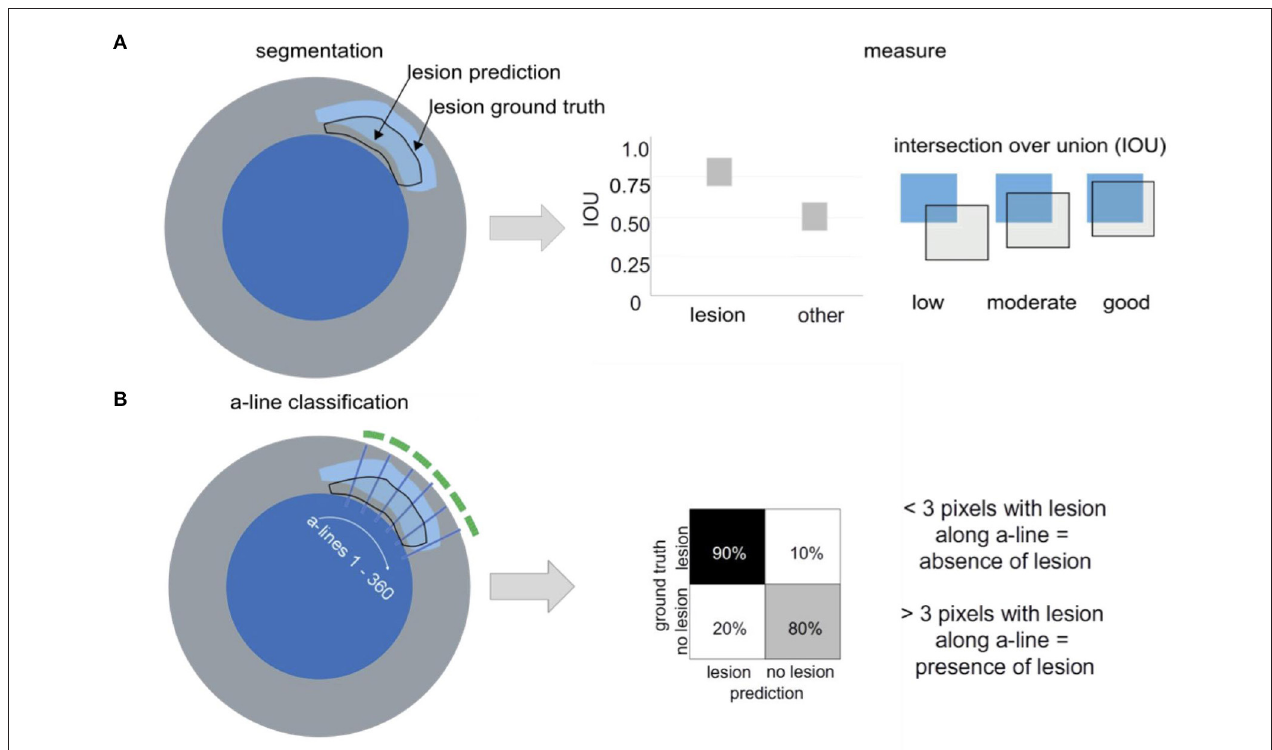
FIGURE 2 | Lesion segmentation vs. a-line classification. (A) Lesion segmentation: Atherosclerotic lesions are annotated in OCT frames with or without histopathological information (blue = lumen, gray = vessel wall). Performance of the segmentation approach is evaluated via IOU, measuring the overlap between the labeled “ground truth” and the “prediction” of the algorithm. IOU ranges between 0 and 1 (B) a-line classification. Based on the manual annotation, 360 a-line predictions are evaluated per OCT frame regarding the presence or absence of atherosclerotic lesions and can be summarized in a confusion